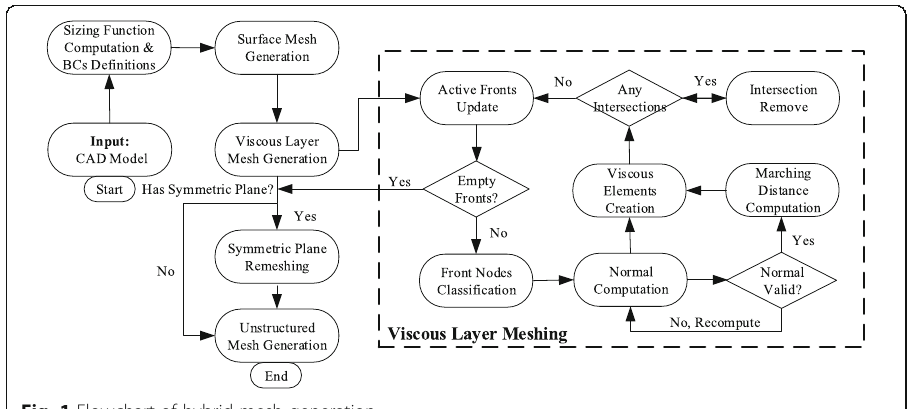
Fig. 1 Flowchart of hybrid mesh